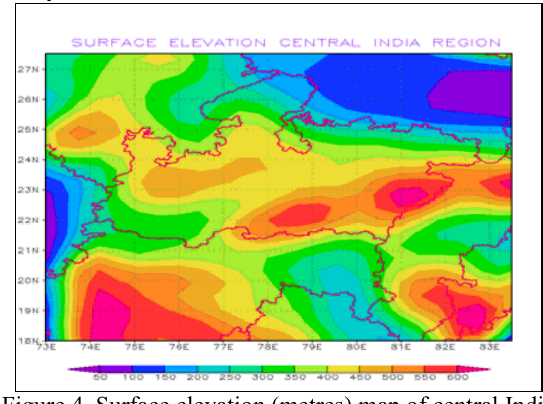
Figure 4. Surface elevation (metres) map of central India